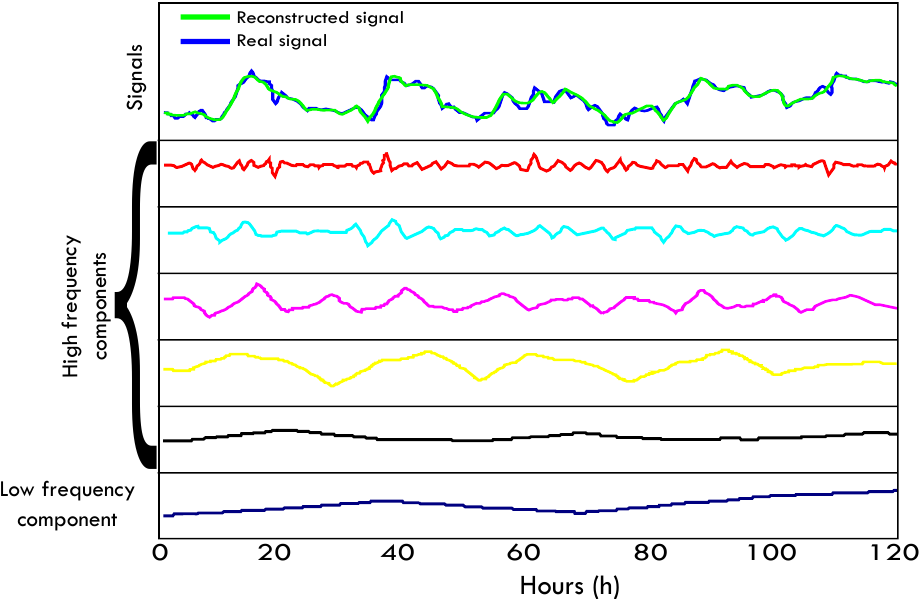
Figure 3. Discrete wavelet transform decomposition